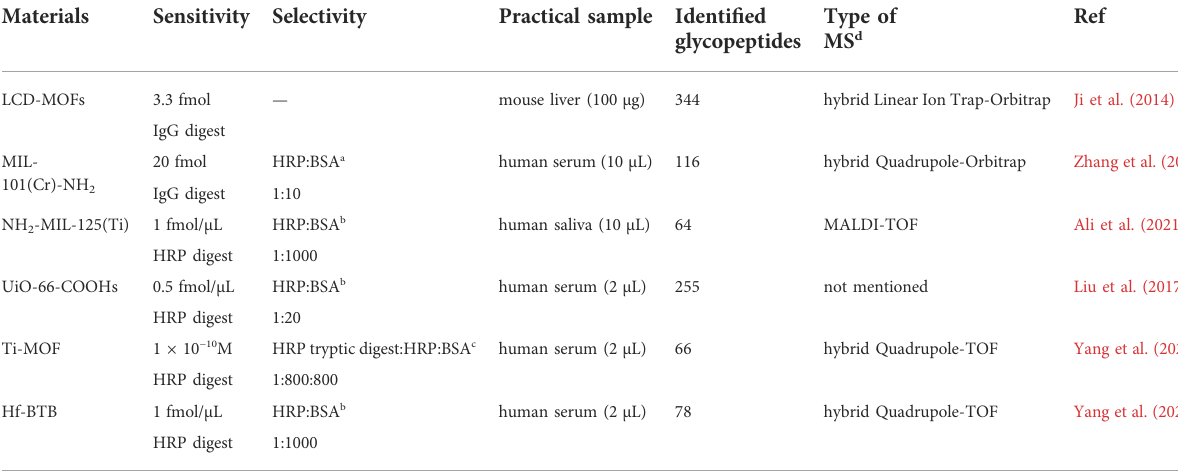
TABLE 1 Representative display of pristine MOFs in glycoproteomics.